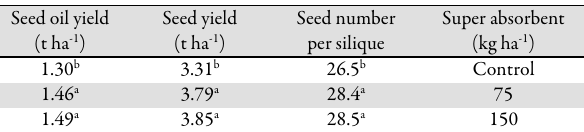
Table 5. Number of seeds per silique, seed yield and seed oil yield by super